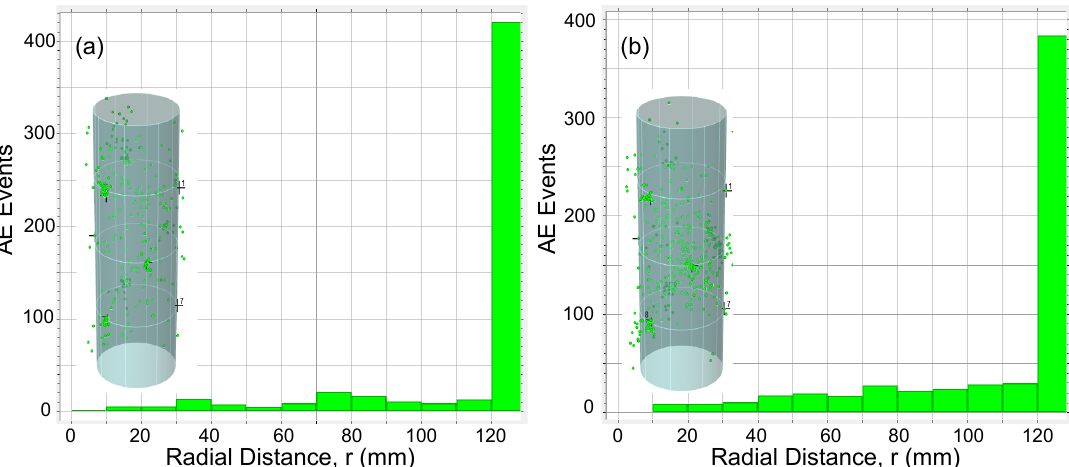
Figure 15. AE events along specimen F12S100L cross section for ( a ) t < 722s and ( b ) t ≥